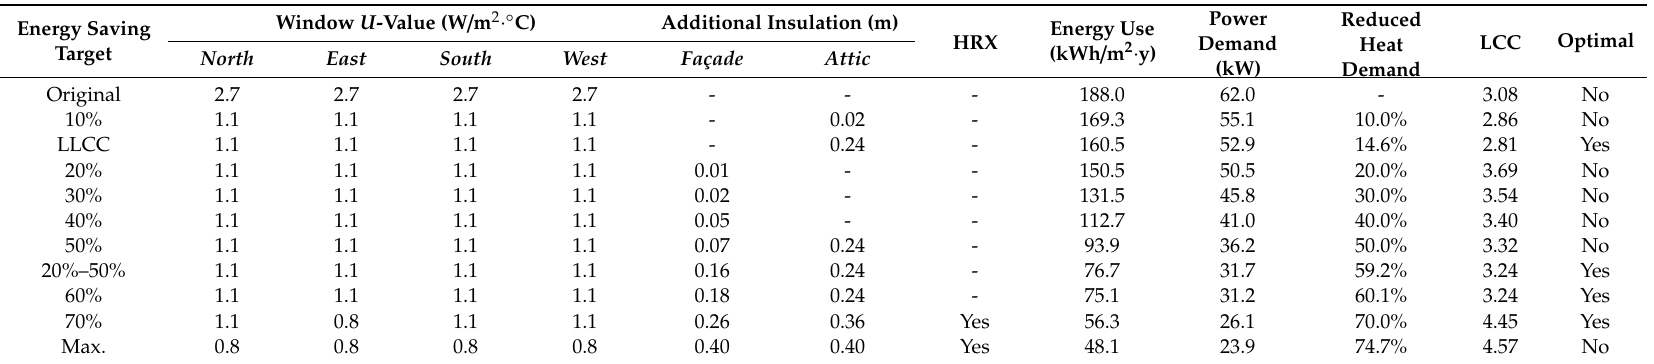
Table 14. EEMs at di ff erent energy saving targets between 10% and 70% for the 1940s building. LLCC—lowest LCC.